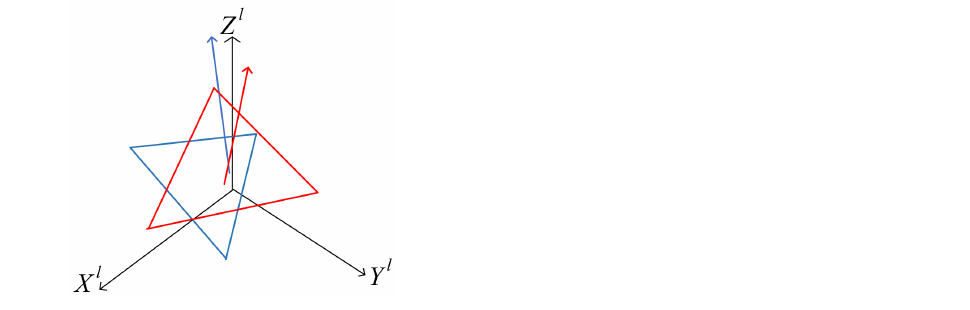
Figure 3. Two fitting planes in the lidar coordinate